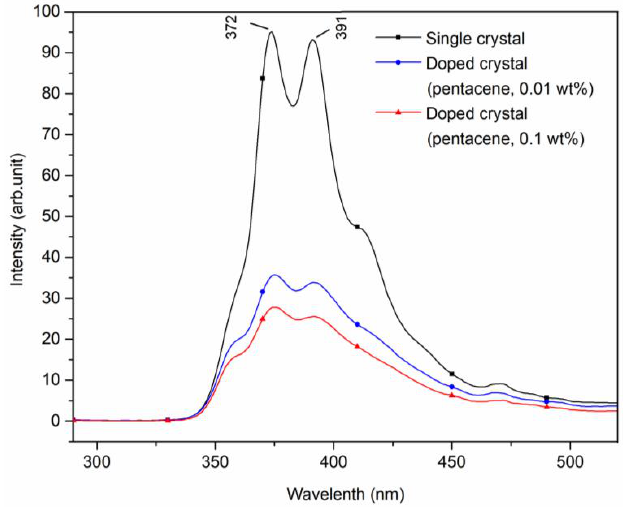
Figure 4. Fluorescence spectra of pure and pentacene-doped p-terphenyl crystals ( λ ex = 270 nm).